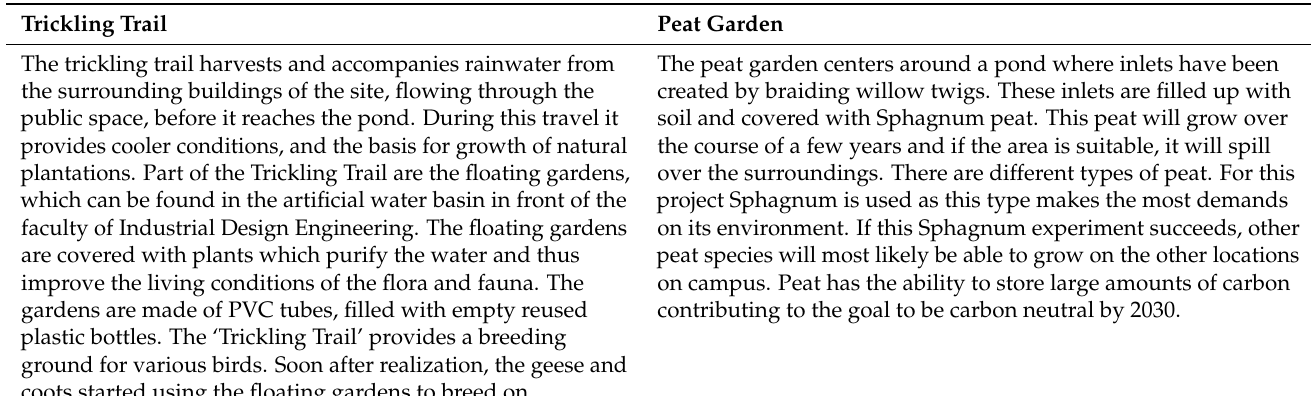
Table 1. Brief description of four realized eco-campus